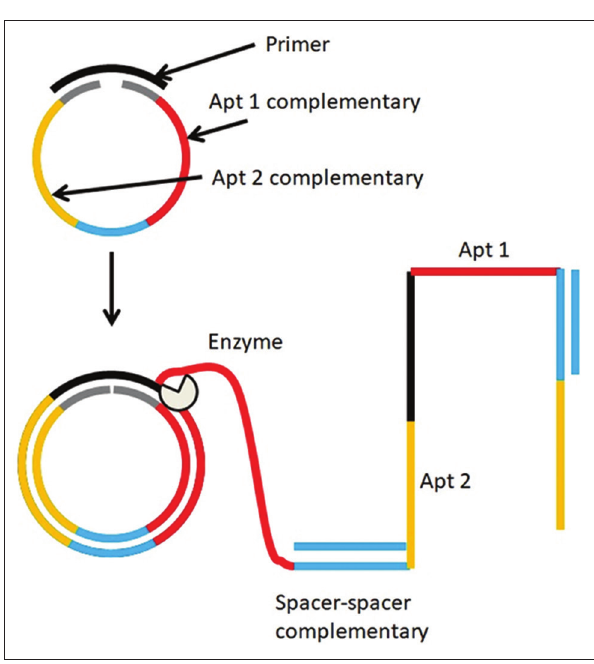
Figure-1: Rolling circle amplification technique. Template is designed to have the complementary sequences of aptamers 1 and 2 (Apt1 and Apt2) with primer-binding site and spacer. When the enzyme rolls on the template during the amplification process, it creates tandem repeats of the aptamers. However, spacer complementary sequence is added to create rigid, double-stranded DNA stretches along the rolling circle amplification products.